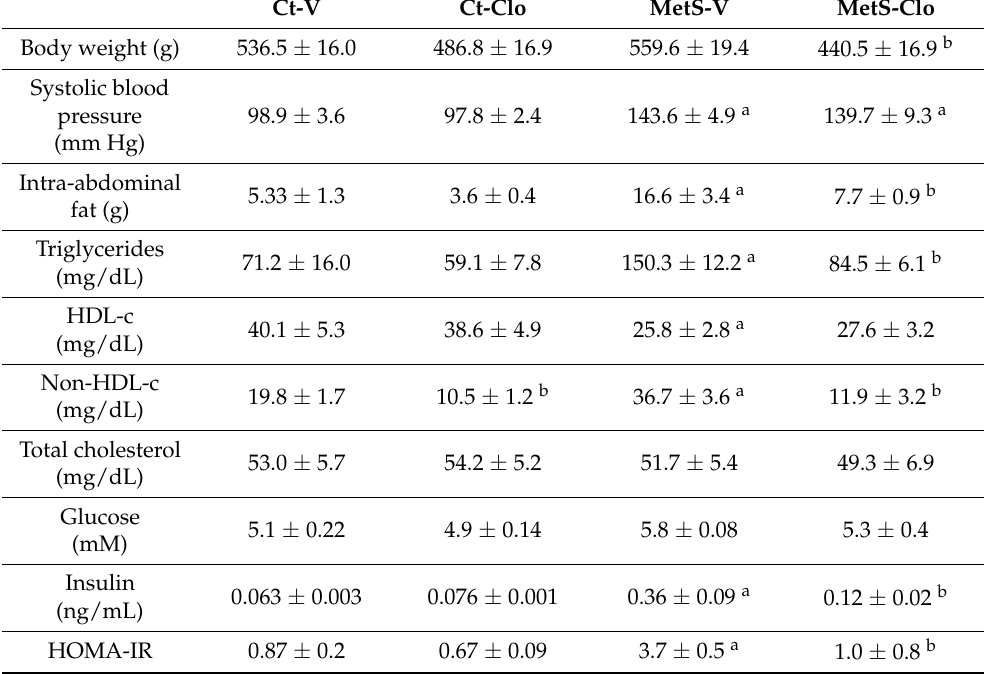
Table 1. Effect of clofibrate on the general characteristics and serum parameters of control and MetS rats. Ct-V Ct-Clo MetS-V MetS-Clo Body weight (g) 536.5 ±